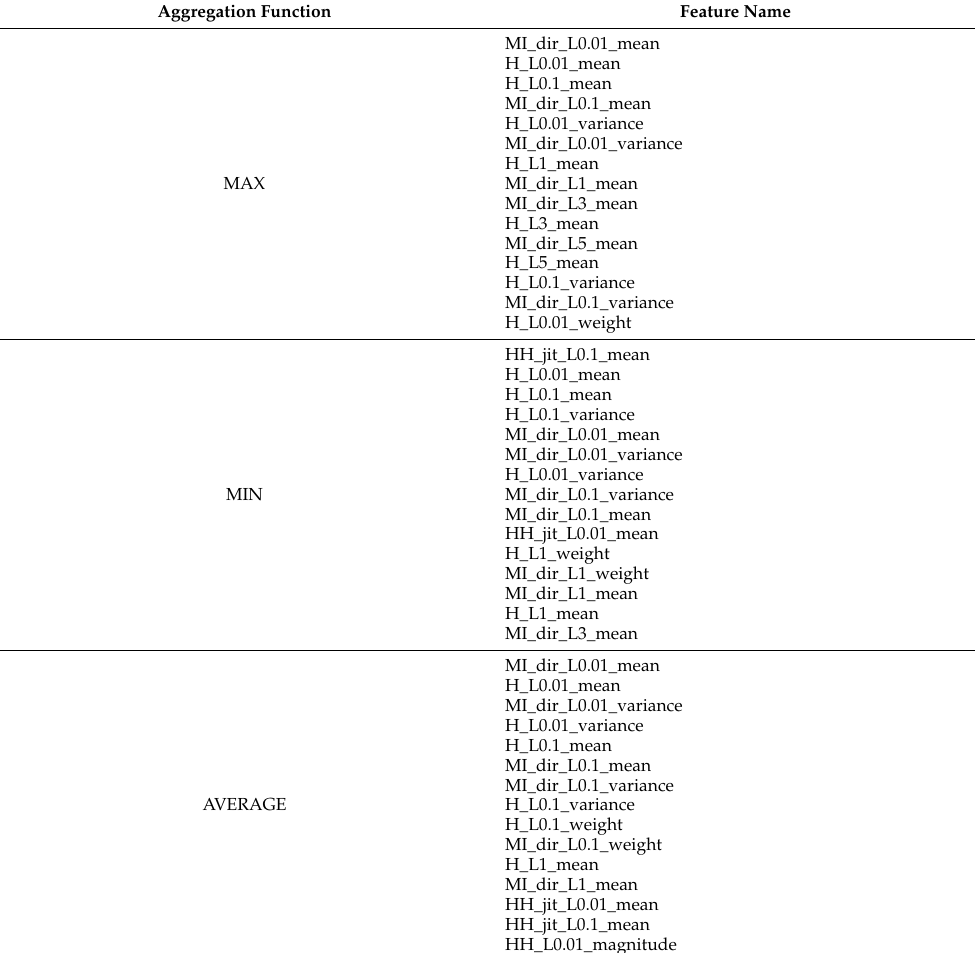
Table 8. Top 10% of Selected Features: The features are sorted in descending order with respect to MI score.